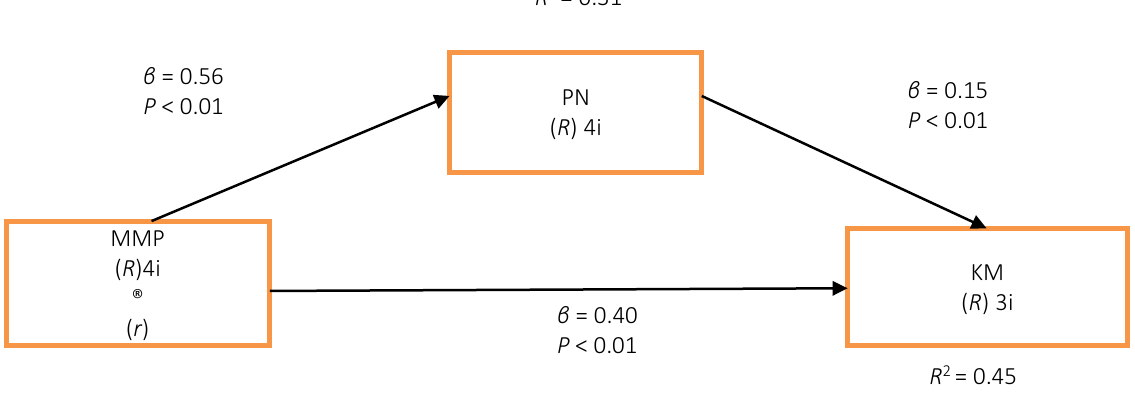
Figure 2. Structural equation model coefficient. The Role of Perceived Value as a Mediator for Political Marketing Mix on Decision to Vote Head of